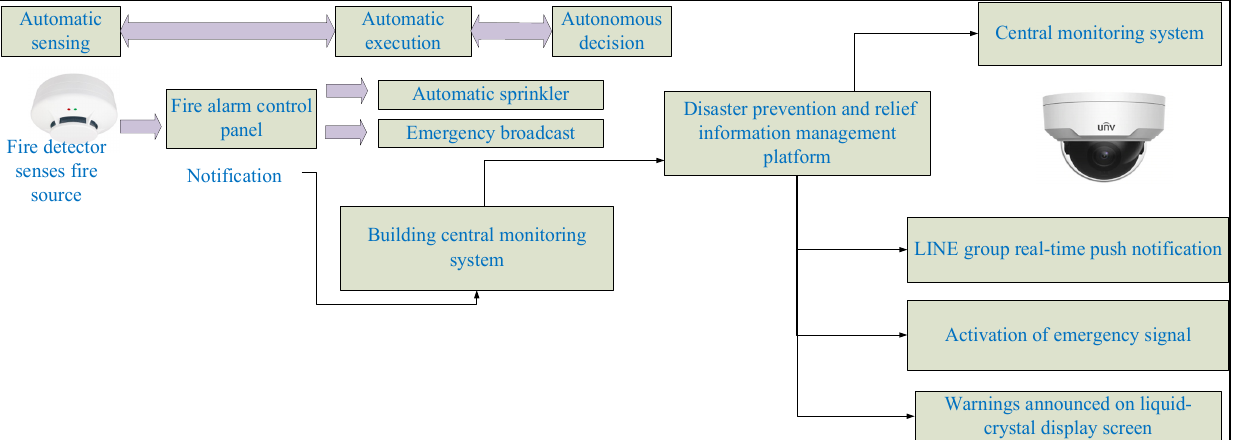
Figure 5. System architecture of the automatic sensing and automated decision-making of equipment. (Source: Taipei Main Station Intelligent Joint Disaster Prevention Center,